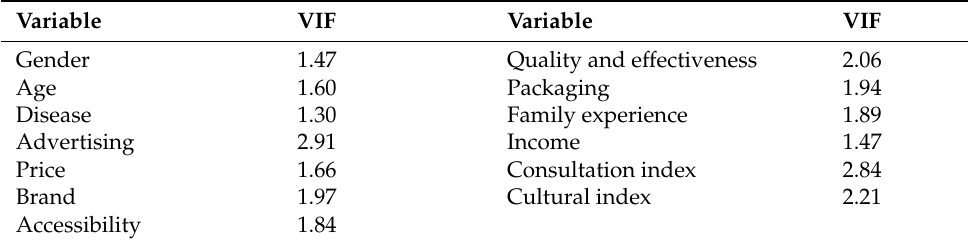
Table 3. The results of multicollinearity test between independent variables using VIF.